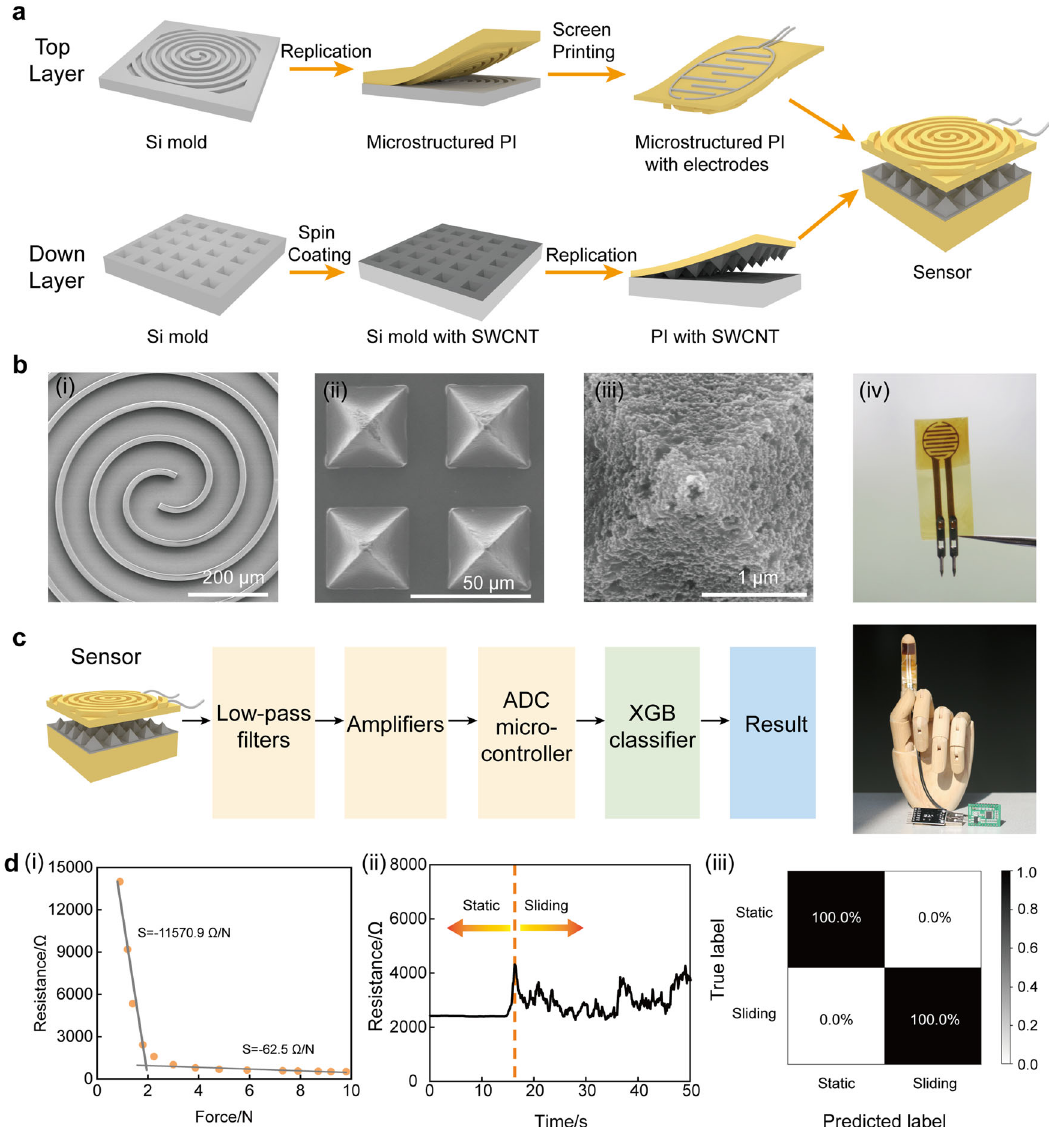
Fig. 2 The fabrication, characterization and performance of the tactile sensor. a A schematic illustration of the fi ngertip-inspired sensor fabrication process. b Scanning electron microscopy (SEM) images and optical image of the sensor. (i) the top fi ngertip-inspired layer. (ii) the down micropyramid layer. (iii) the single carbon nanotube partially embedded in the patterned surface. (iv) the optical image of the sensor. c The integration of the multifunction tactile system, showing analog signal acquisition, processing(orange) and machine-learning recognition (green) paths from the sensor to the custom-developed peripherals. d output signals of static and sliding status. (i) responses of the tactile sensor under different normal force. (ii) real-time responses of the sensor from static to sliding state with a constant normal force (2 N) and a constant sliding velocity (100 mm min − 1 ). (iii) The confusion matrix derived from the model made by XGBoost. Predicted label refers to the recognized results, and true label refers to the true state. The color bar represents the normalized